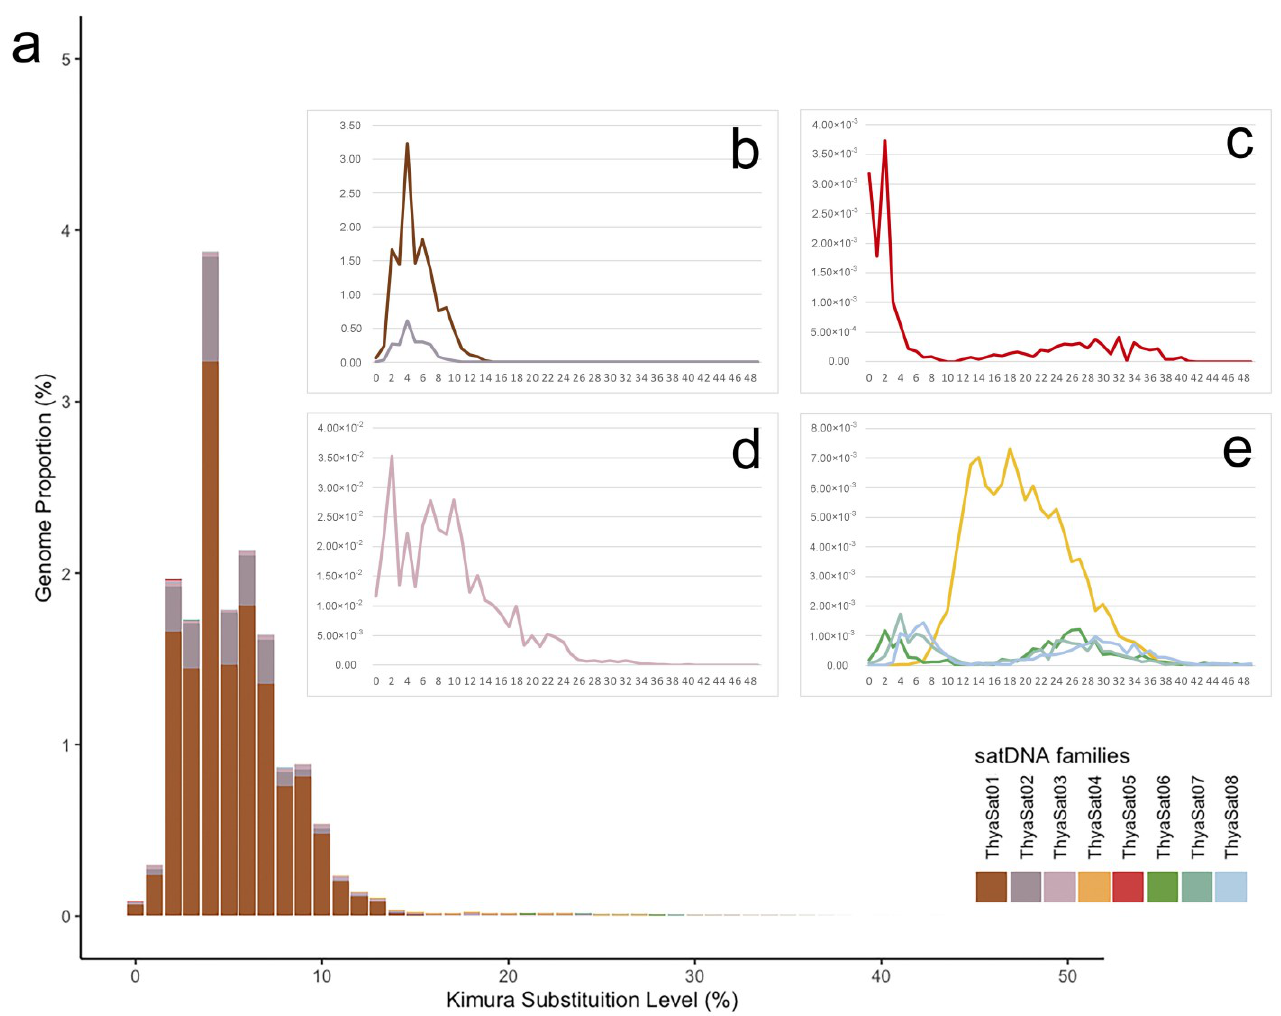
Figure 2. Landscape (abundance versus divergence) for the satDNAs identified on the genome of T. hyalinata through analysis of RepeatExplorer. The abundance and divergence were estimated by RepeatMasker. ( a ) General landscape for all satDNAs. ( b – e ) Show landscapes in more detail for specific satDNA families; ( b ) members of SF1, ThyaSat01-301, and ThyaSat02-300; ( c ) ThyaSat05- 291; ( d ) ThyaSat03-542; ( e ) members of SF2, ThyaSat04-145, ThyaSat06-145, ThyaSat07-145, and ThyaSat08-145.